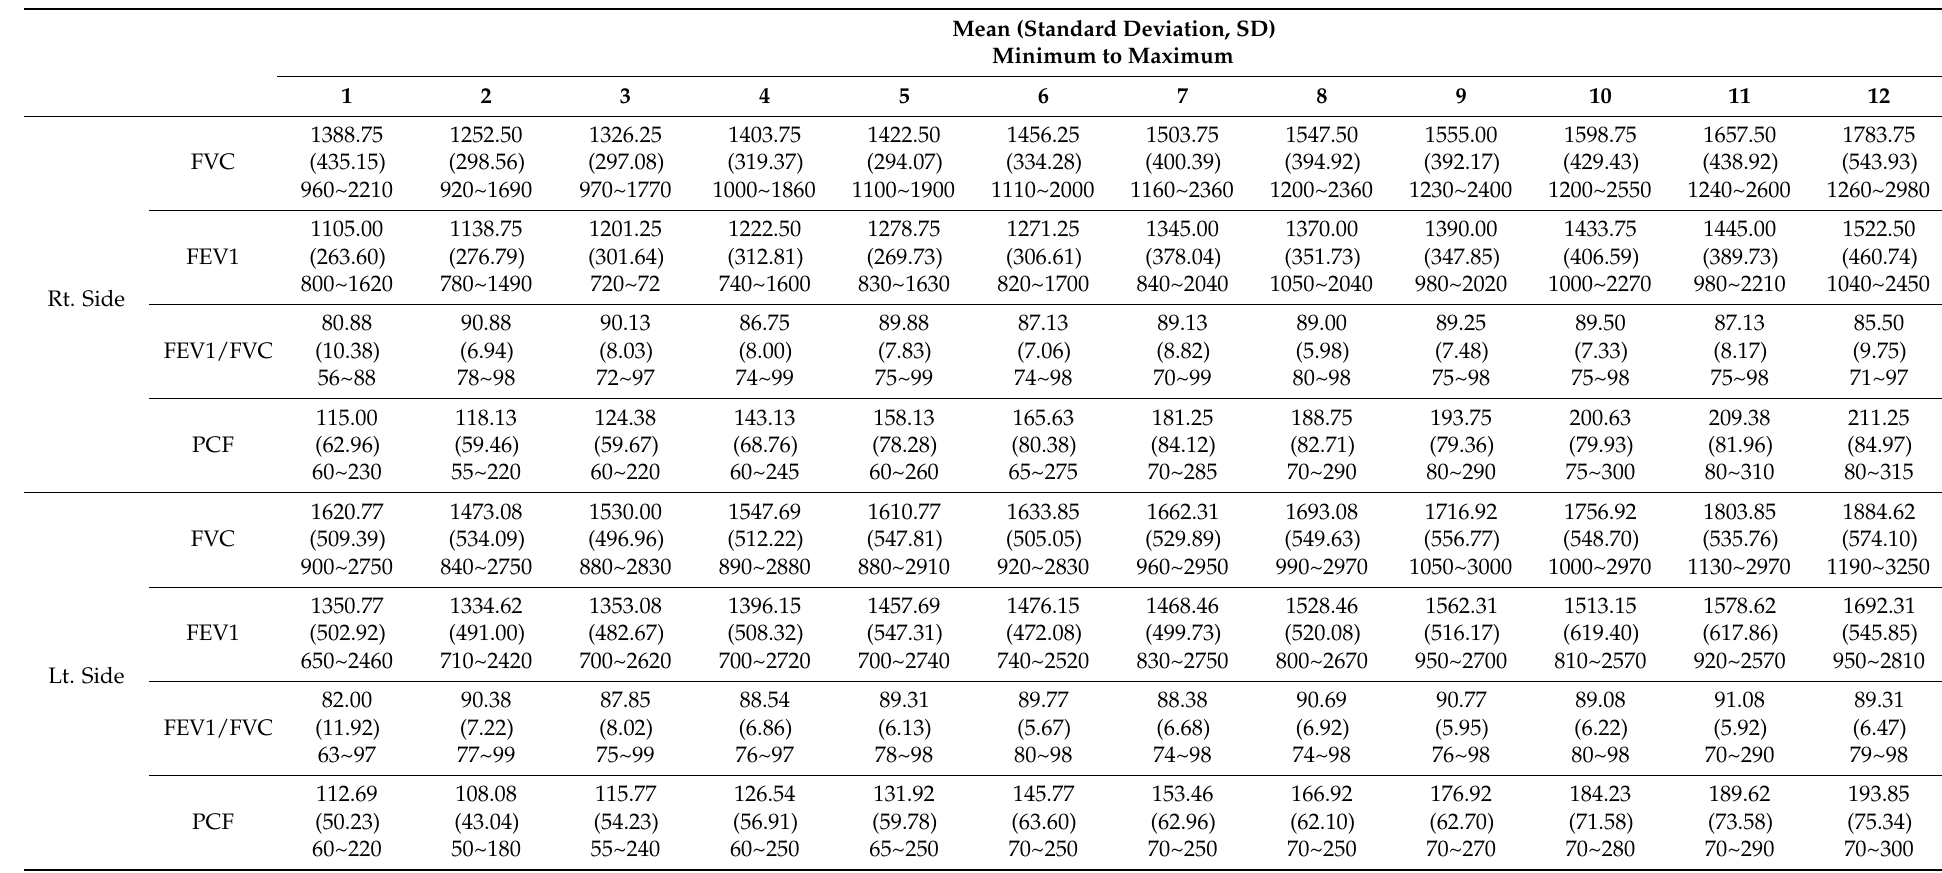
Table 5. Descriptive statistics results of variable